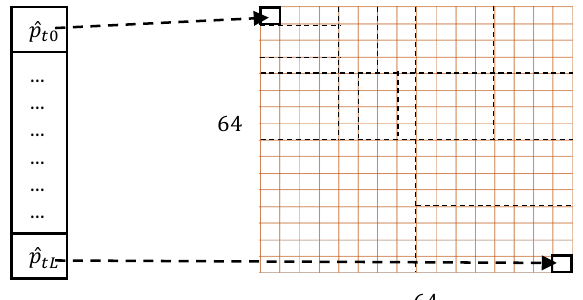
Figure 5. Representation of MTL CNN output vector, L is length of probability vector ˆ p t , and t is the intra-coding